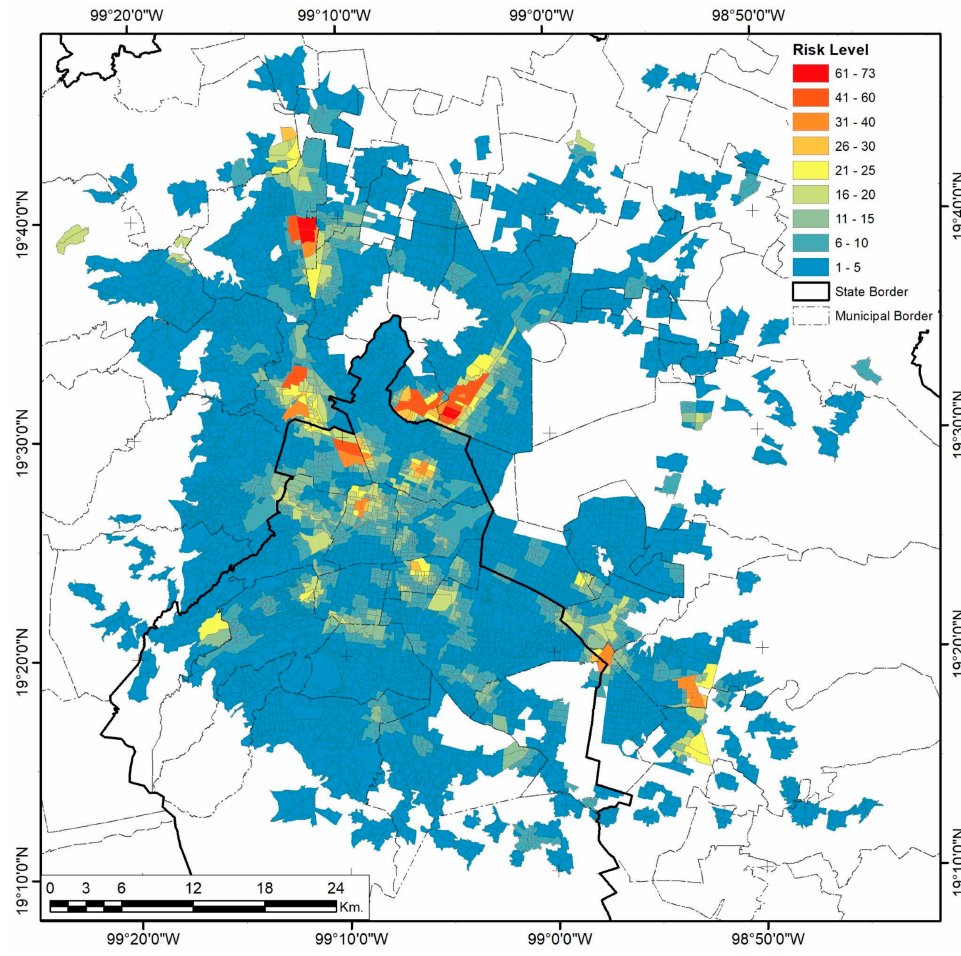
Figure 13. Mexico City risk level by